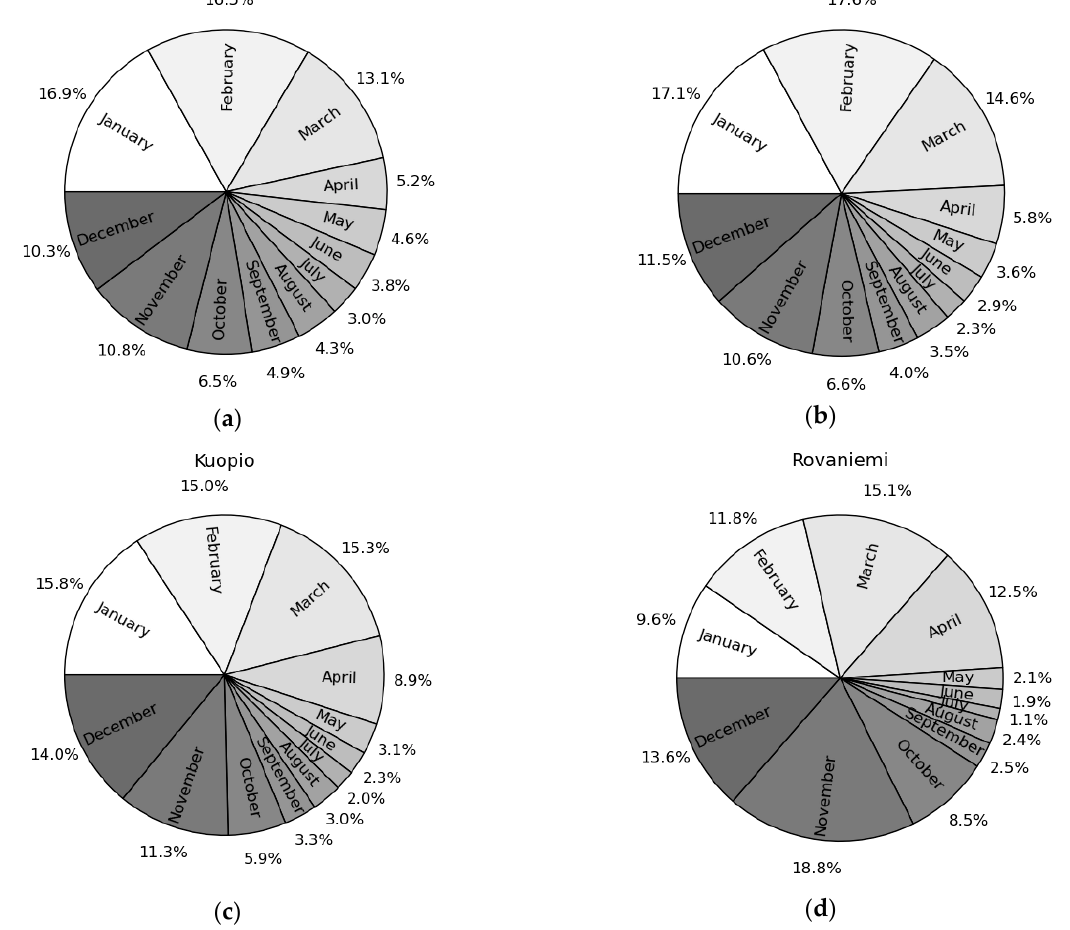
Figure 2. Pie charts showing the portion of each month’s slip injuries based on the TVK’s data for Helsinki ( a ), Tampere ( b ), Kuopio ( c ) and Rovaniemi ( d ) with a time range between 1 October 2005, and 30 September 2019. Different shades of gray present different months from January (white) to December (dark gray). Figures for all cities are presented in the Supplementary Material (Figure S1).